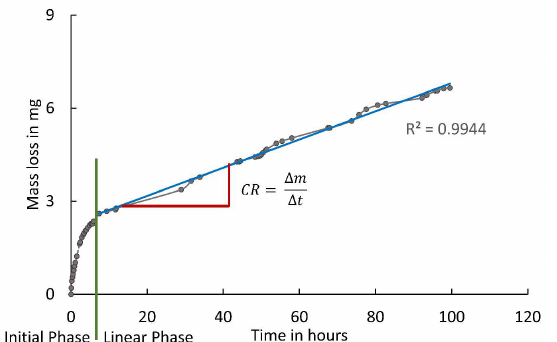
Figure 3. An exemplary procedure for calculating the corrosion rate according to Nidadavolu et al. [26]. The linear phase of the curve is identified (start of the linear phase at the green line). The linear part of the curve is approximated with a linear regression (blue). The interception value/corrosion rate can be